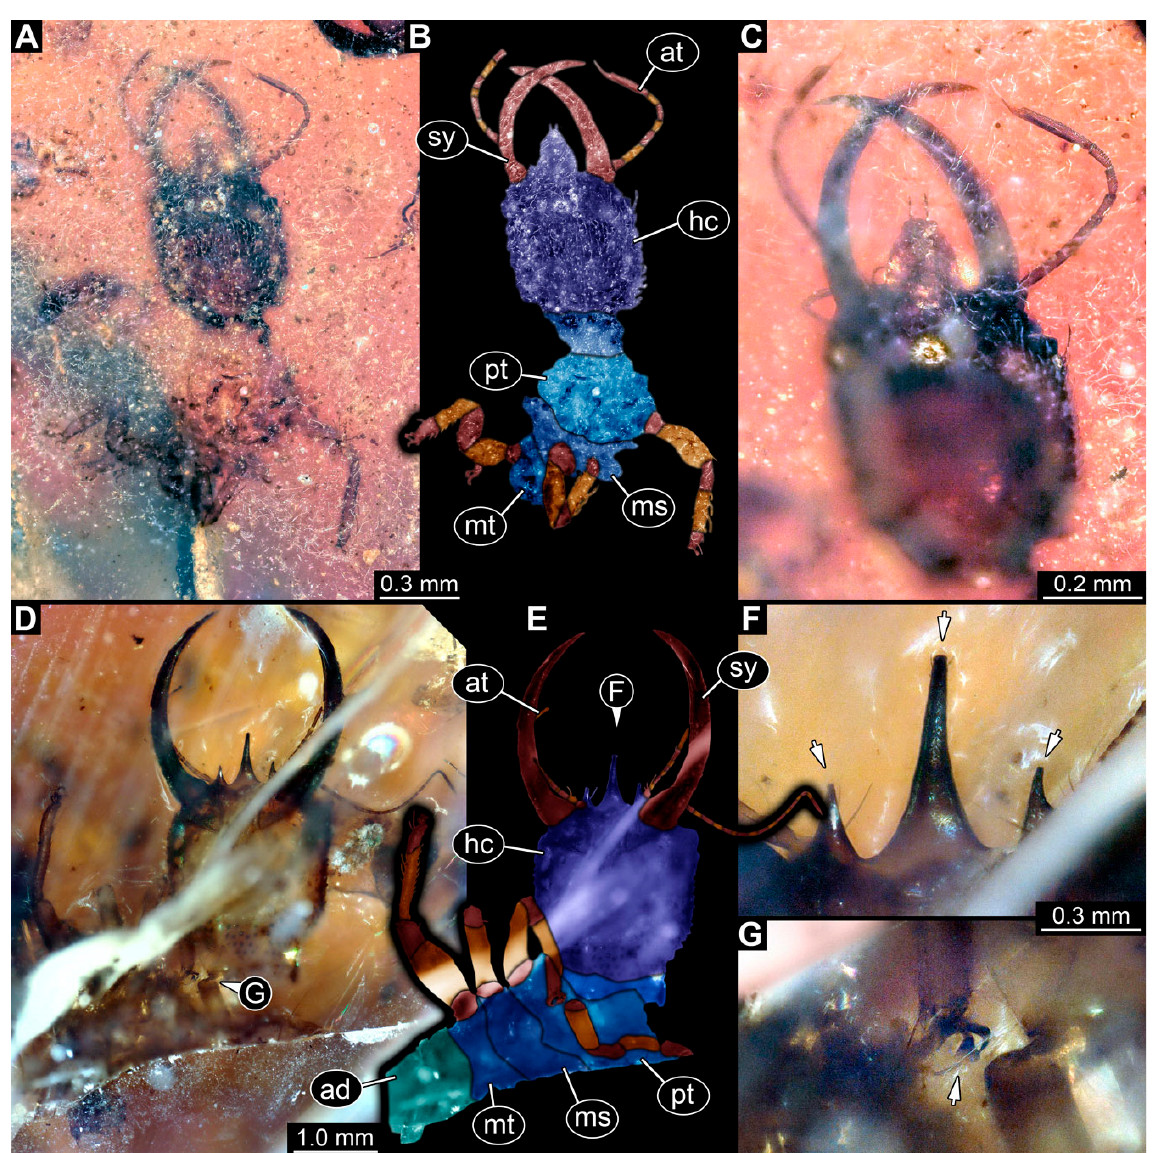
Figure 11. Specimens in Myanmar amber. ( A – C ) Specimen 70 (PED 0774). ( A ) Ventral view. ( B ) Ventral view, colour-marked. ( C ) Close-up of head capsule, ventral view. ( D – G ) Specimen 69 (PED 0751). ( D ) Ventral view. ( E ) Ventral view, colour-marked. ( F ) Close-up of labrum, ventral view; arrows mark spine-like protrusions. ( G ) Close-up of first locomotory appendage; arrow marks empodium. Abbreviations: ad = abdomen; at = antenna; hc = head capsule; ms = mesothorax; mt = metathorax; pt = prothorax; sy =